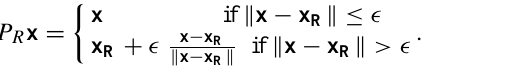
Fig. 4. Example GUVI electron density reconstructions during the SpreadFEx.